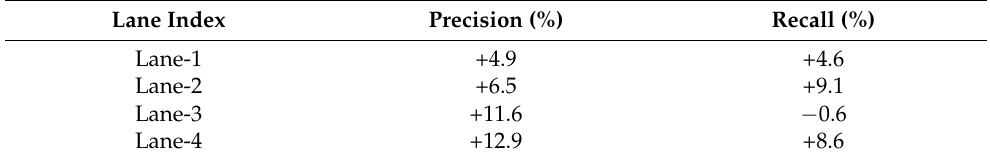
Table 10. The comparison between single head ResNet18 and dual-head LLNet (vision image only). Lane